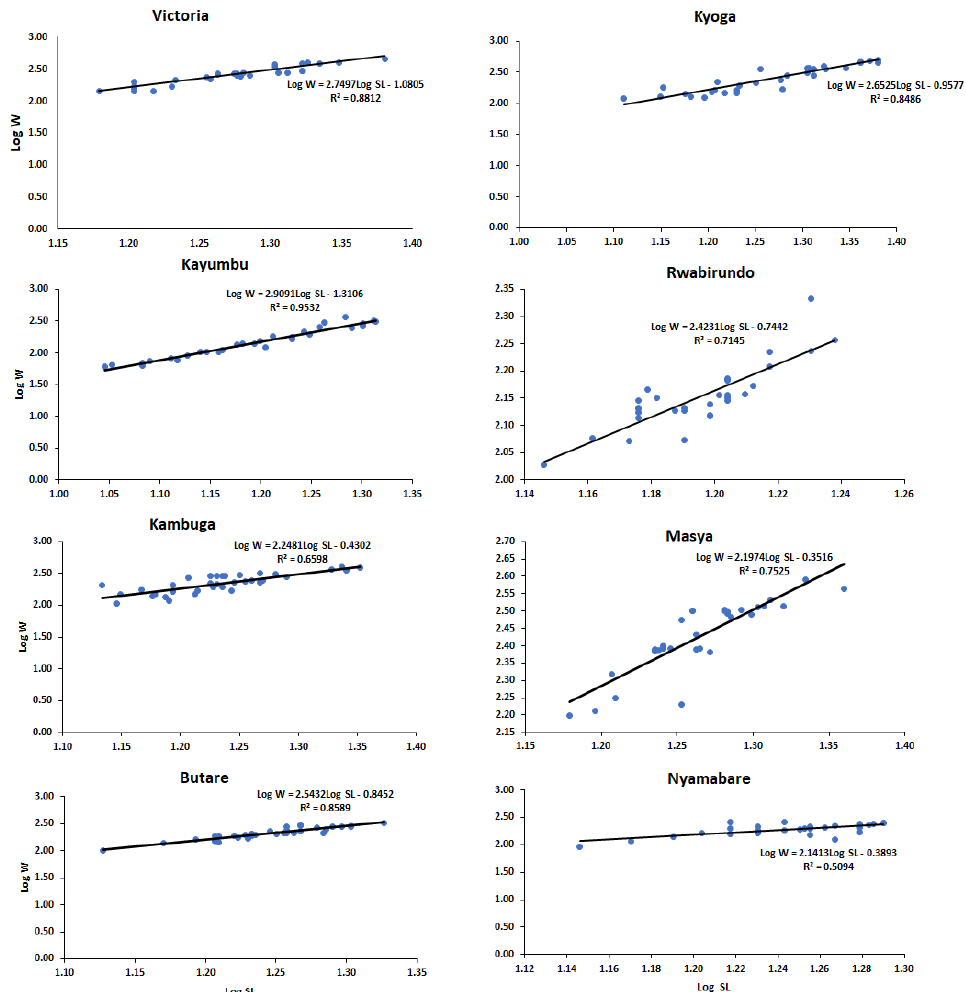
Figure 3. Length–weight relationships of the population of O. niloticus in the sampling sites. Relative Condition Factor (K) for the O. niloticus did not differ significantly among the populations ( p > 0.05) [df (8,279), F = 0.27, p = 0.98] (Figure 4). All the populations had an average condition factor (K = 1) (Figure